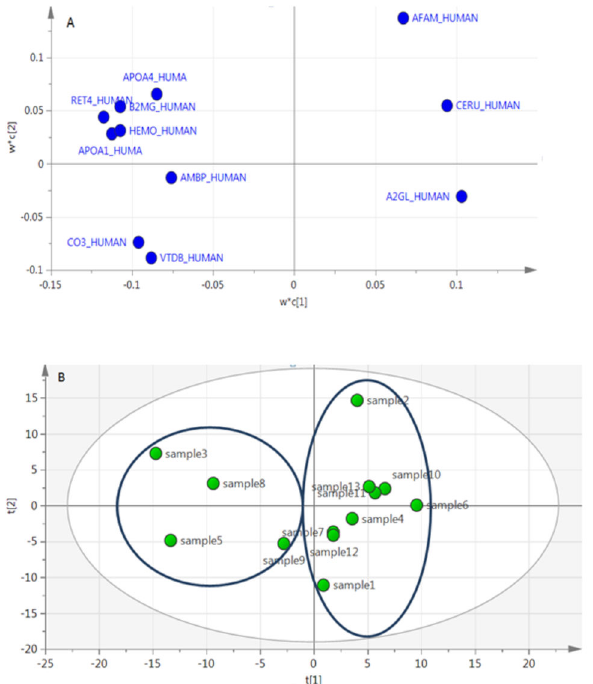
Figure 3. Proteomics-based predictive model using PLS analysis based on loading plot. The variables on the right are under-represented proteins and the variables on the left are over-represented proteins in advanced stage of IgA nephropathy (A). Score plot of Predictive model (B).